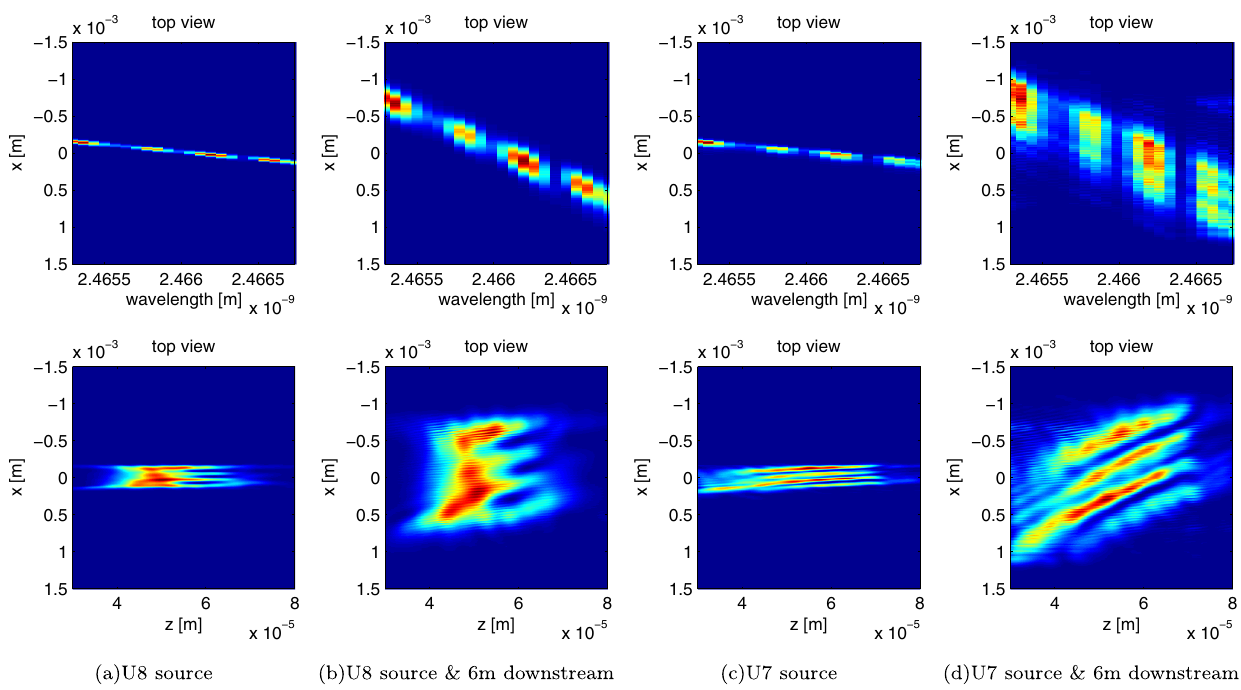
FIG. 20. Frequency (first row) and time domains (second row) of propagated radiation pulse through the monochromator. The direct approach with a limited spectral bandwidth was used for propagation. The radiation source position was simulated in undulator 8 (a – b) and in undulator 7 (c – d). In order to illustrate further evolution of the pulse, it was additionally propagated 6 m downstream seeded undulator (b,d). The radiation energy is 500 eV. At higher energies this effect is